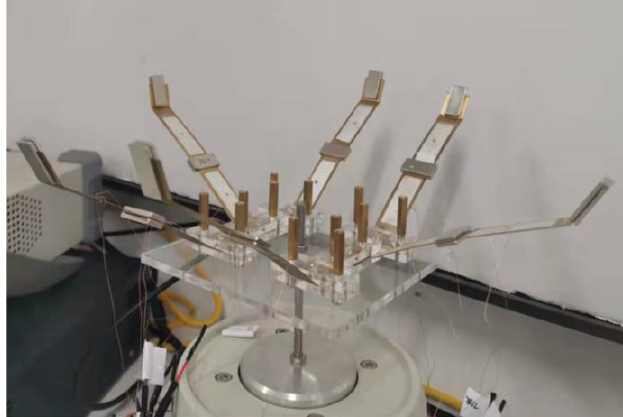
Figure 19. Sextuple array structure installation.